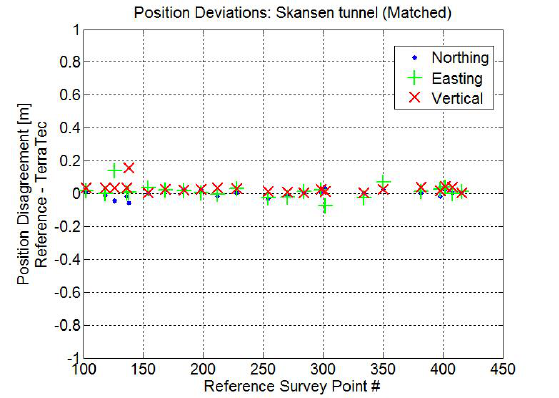
Figure 6: TerraTec system solution deviations relative to the refer- ence measurements when matching is utilized, Skansen